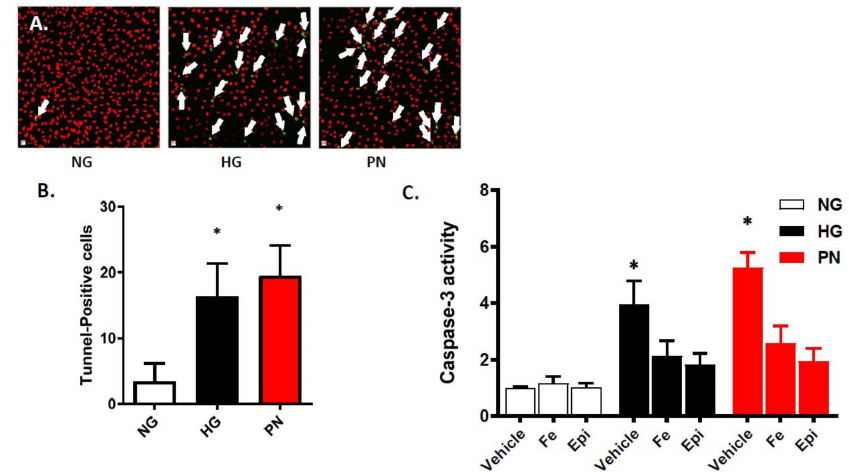
Figure 1. High glucose and peroxynitrite accelerated apoptosis in epithelial cell (EC) cultures. ( A ) Representative micrographs of TUNEL-positive nuclei (green, indicated by white arrows) in EC cultures counterstained with propidium iodide (red), and images were taken at 20 × magnification. ( B ) Statistical analysis using one-way ANOVA showing significant increase in the number of TUNEL-positive cells in ECs treated with high glucose (HG, 25 mM) for 3 days or peroxynitrite (PN, 0.5 mM) for overnight, compared with normal glucose (NG) controls. (* p < 0.05, n = 6). ( C ) Statistical analysis of caspase-3 enzyme activity using two-way ANOVA showed significant interaction among examined groups. Treatment of EC cultures with HG (25 mM) for 3 days or PN (0.5 mM) overnight significantly increased activity of caspase-3 compared to NG. Co-treatment with the specific peroxynitrite decomposition catalyst FeTTPs (Fe, 2.5 µ M) or the nitration inhibitor epicatechin (Epi, 100 µ M) significantly reduced the increase in caspase-3 activity. (* p < 0.05, significant using Bonferroni test compared to the rest of the groups, n =